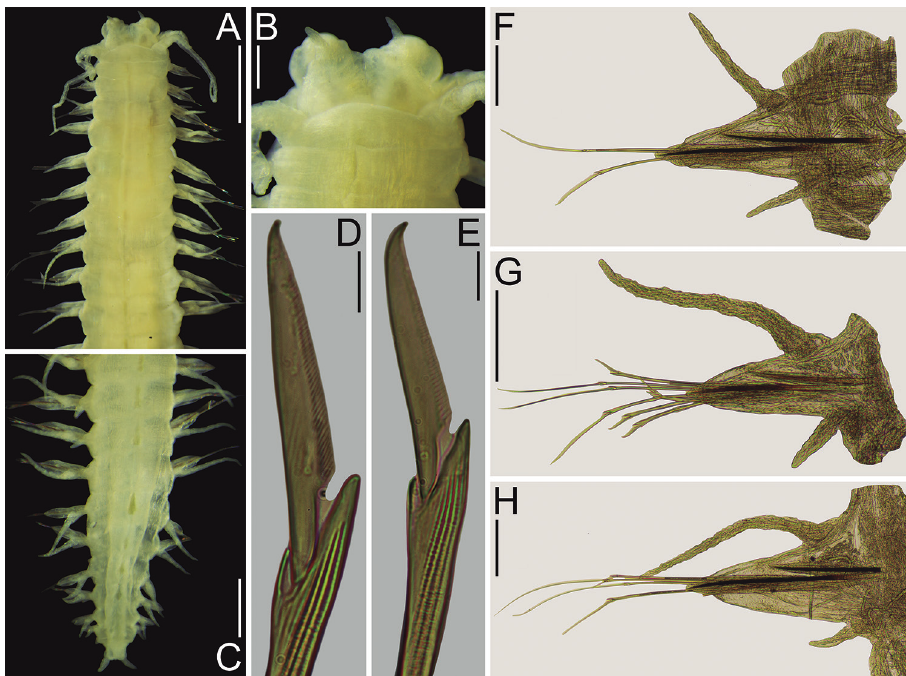
Figure 1. Namanereis cavernicola (Solís-Weiss & Espinasa, 1991). A–H Paratype USNM 136559 A An- terior end, dorsal view B Close-up of prostomium C Posterior end, dorsal view D Supra-acicular falciger, chaetiger 62 E Sub-acicular falciger, chaetiger 62 F Chaetiger 5, right parapodium G Chaetiger 20, right parapodium H Chaetiger 62, right parapodium. Scale bars: 1 mm ( A ); 0.2 mm ( B , F–H) ; 0.5 mm ( C ); 10 µm ( D , E